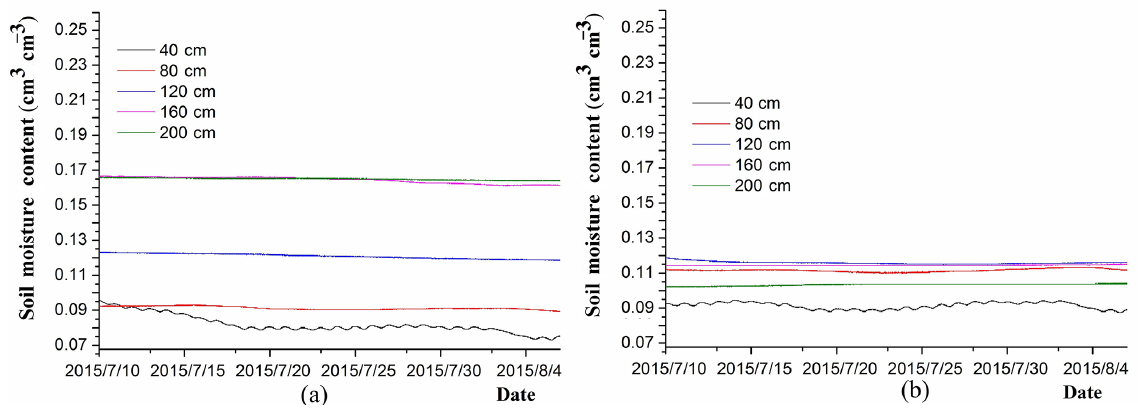
Figure 2. Soil moisture (0–200cm) dynamics during the sampling period: (a) native grasses with a shallow root system and (b) Caragana korshinskii with a deep root